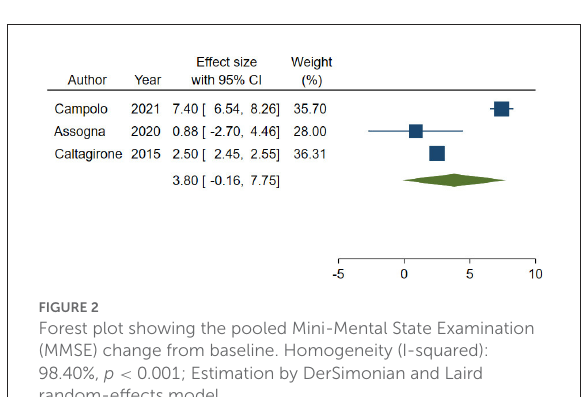
FIGURE2 Forest plot showing the pooled Mini-Mental State Examination (MMSE) change from baseline. Homogeneity